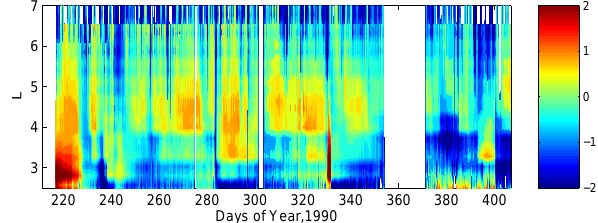
Fig. 2. Logarithm of ratio of 0.95MeV HEEF CRRES electron fluxes to those produced by the optimized radial diffusion